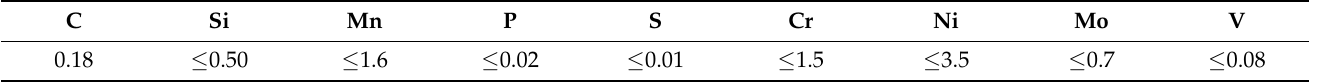
Table 2. Chemical composition of E690 high-strength steel by mass fraction